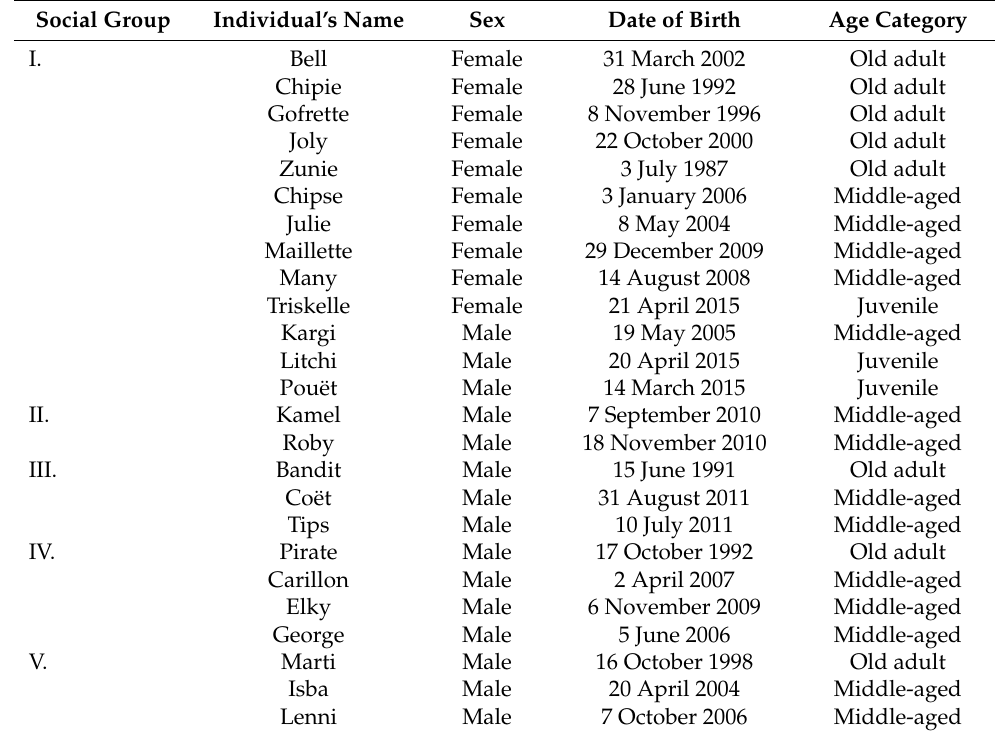
Table 1. Characteristics of the red-capped